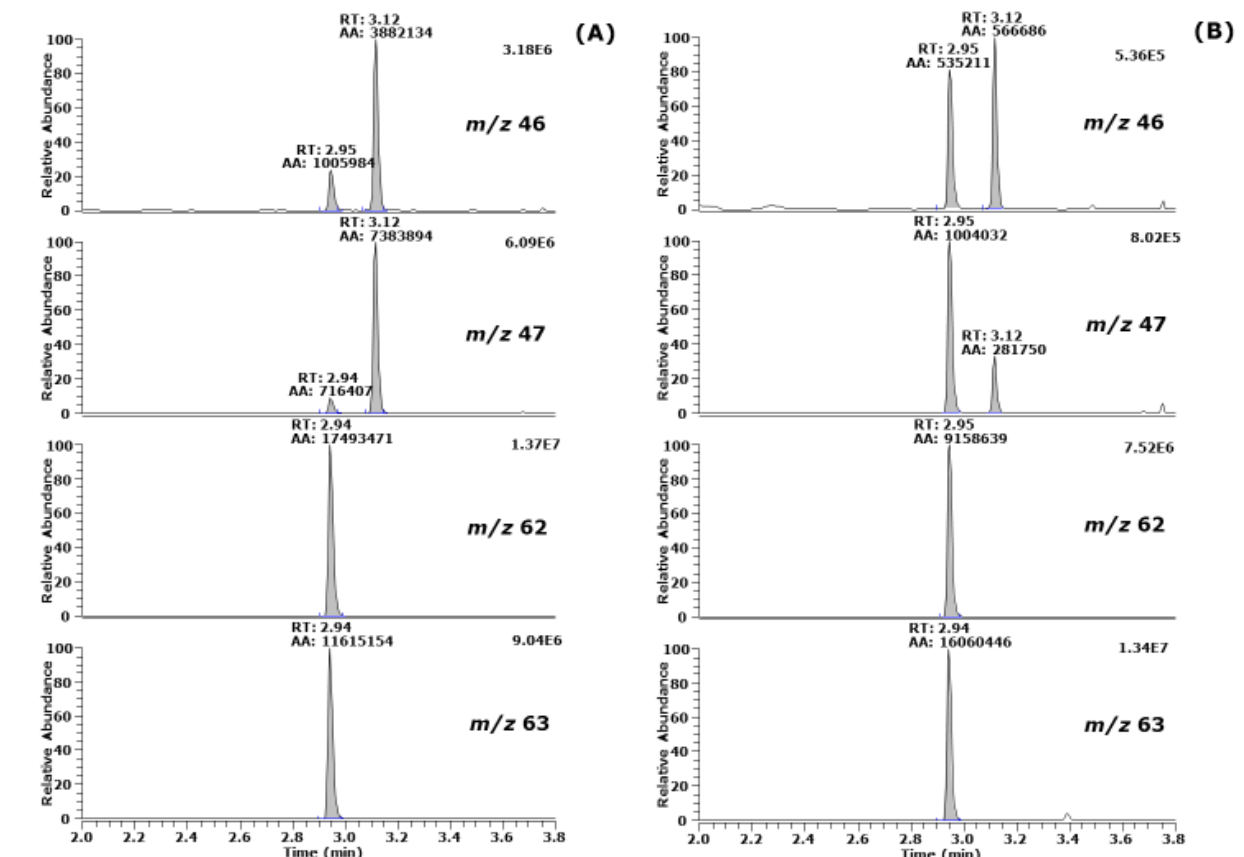
Figure 3. Representative partial GC-MS chromatograms from the simultaneous analysis of nitrite and nitrate in human urine samples without external addition of NaHCO 3 ( A ) and with addition of 100 mM NaHCO 3 ( B ). Derivatization with PFB-Br for 60 min at 50 °C in aqueous acetone was performed. The concentrations of the internal standards in the urine samples were 400 µM [ 15 N]nitrate and 4 µM [ 15 N]nitrite. GC-MS analysis was performed using selected-ion monitoring of m/z 46 for [ 14 N]nitrite, m/z 47 for [ 15 N]nitrite, m/z 62 for [ 14 N]nitrate and m/z 63 for [ 15 N]nitrate. The retention time (RT) was